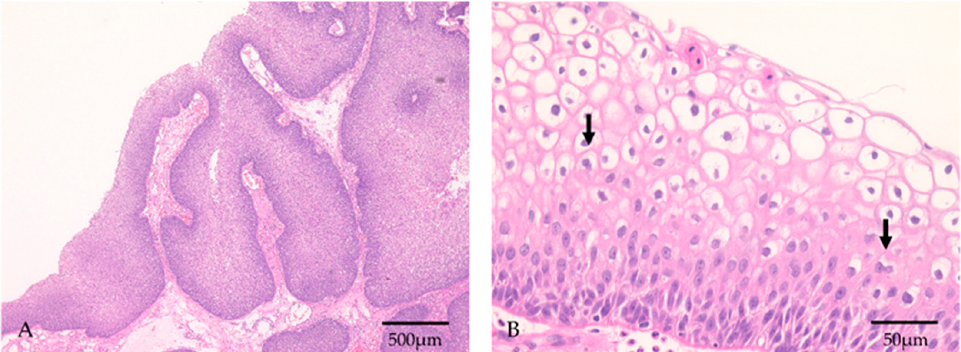
Figure 1. Histopathological features of HPV-positive SNIP. ( A ): The squamous epithelium showed an inverted growth pattern. Objective magnification: 4×. ( B ): Koilocytosis was observed, which has a perinuclear halo. Some koilocytes showed nuclear atypia and binuclear cells (arrows). Objective magnification: 40×.